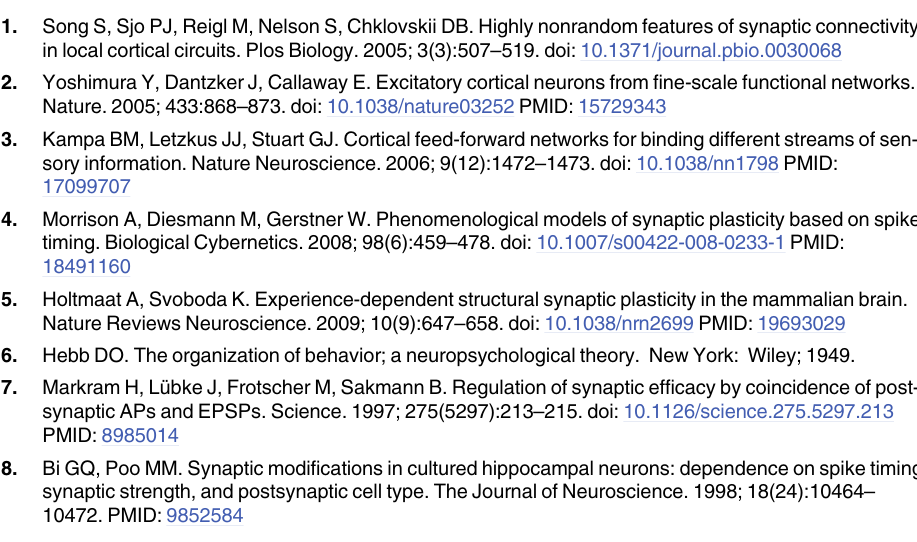
(TIF) S4 Fig. Formation of synfire chains under non antisymmetric STDP dynamics. A. Chain score of the steady state connectivity, obtained from simulations of the complete dynamics (Eq 2) with a non antisymmetric STDP function (see Methods). Horizontal axis: synaptic latency. Each data point represents an average over ten simulations, each with a different realization of the initial random connectivity. B. An illustration of the non antisymmetric STDP function. (TIF) S5 Fig. Contribution of high order motifs as a function of the synaptic latency. A. Contribu- tion of motifs with α − β = 1 weakly depends on the synaptic latency. B. Contribution of motifs with α = β does not depend on the synaptic latency. C. Contribution of motifs with α − β = 2 decays rapidly as a function of the synaptic latency. All the parameters are specified in Meth- ods.